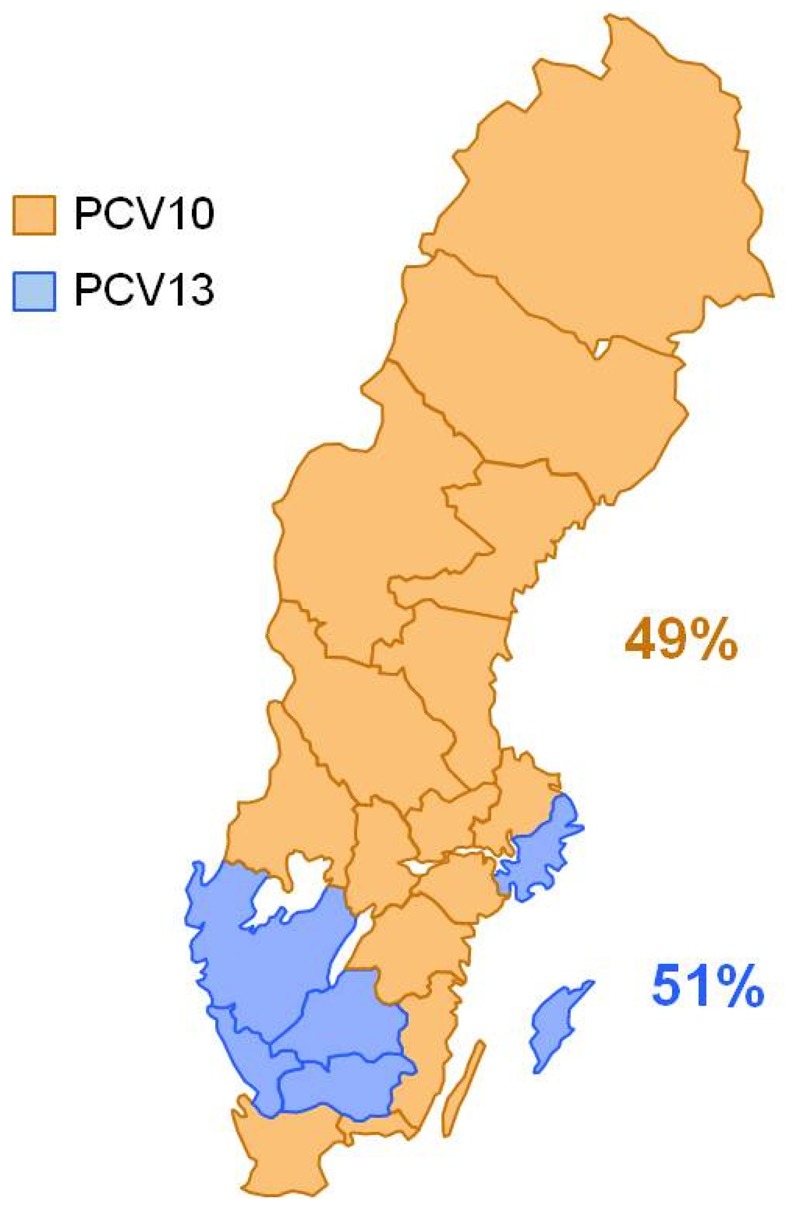
PCV use in 2012 in Sweden by County Council.